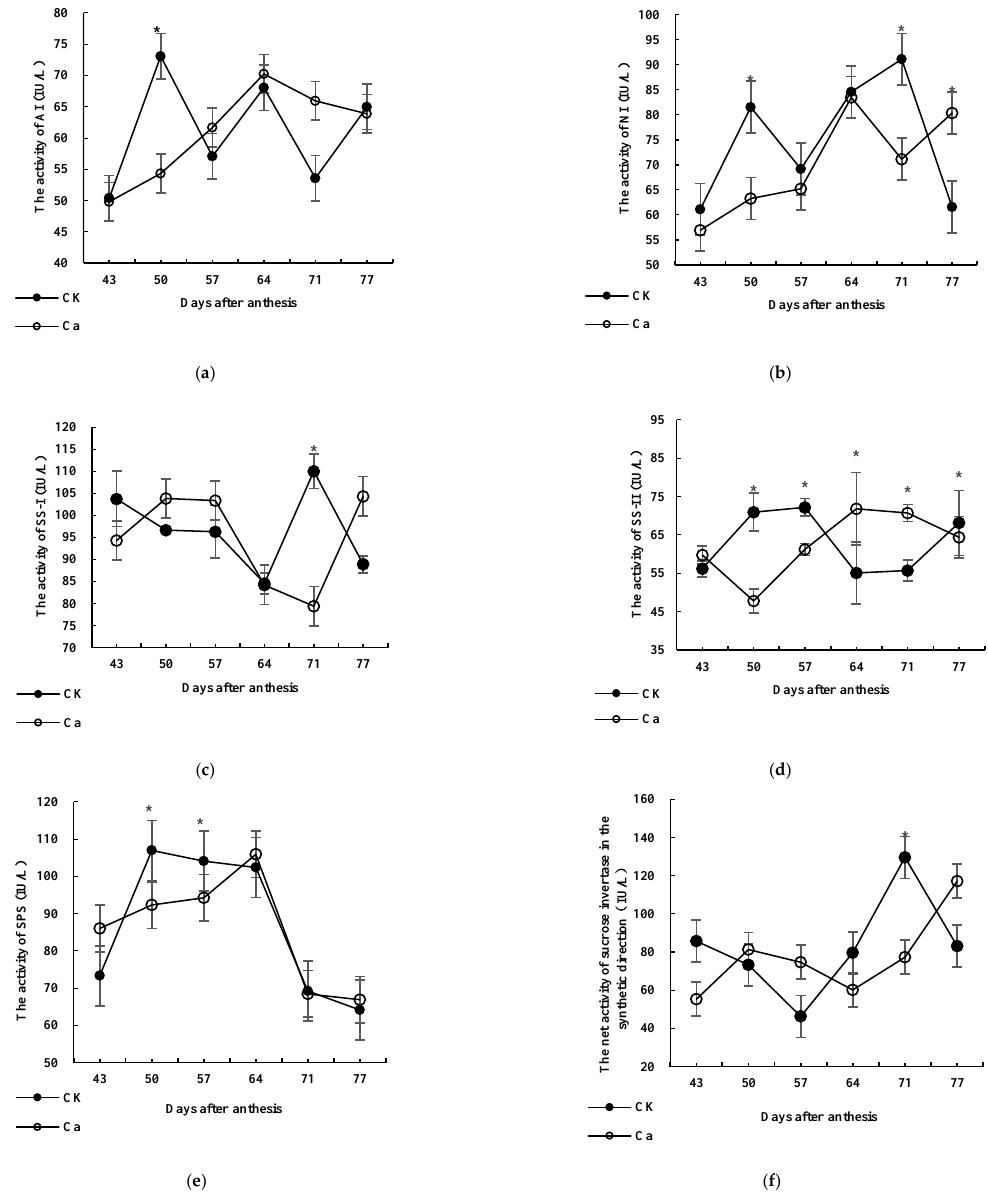
Figure 2. Effects of high-Ca fertilizer on the activities of key enzymes involved in fructose metabolism: ( a ) AI; ( b ) NI; ( c ) SS-I; ( d ) SS-II; ( e ) SPS. ( f ) The net activity of sucrose invertase in the synthetic direction. Note: The symbols with * in the figure indicate significant differences between the CK and high-Ca treatments for the same data type; otherwise, there was no significant difference.